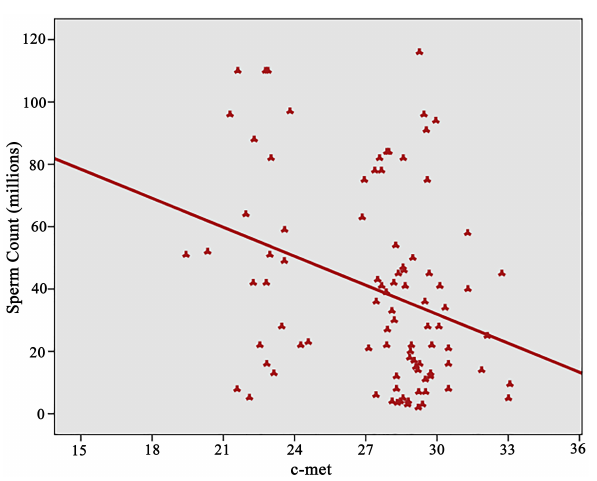
Fig. 1. Correlation between basal sperm count and c-Met ex- pression level in the total cohort (r = –0.309; p = 0.003).